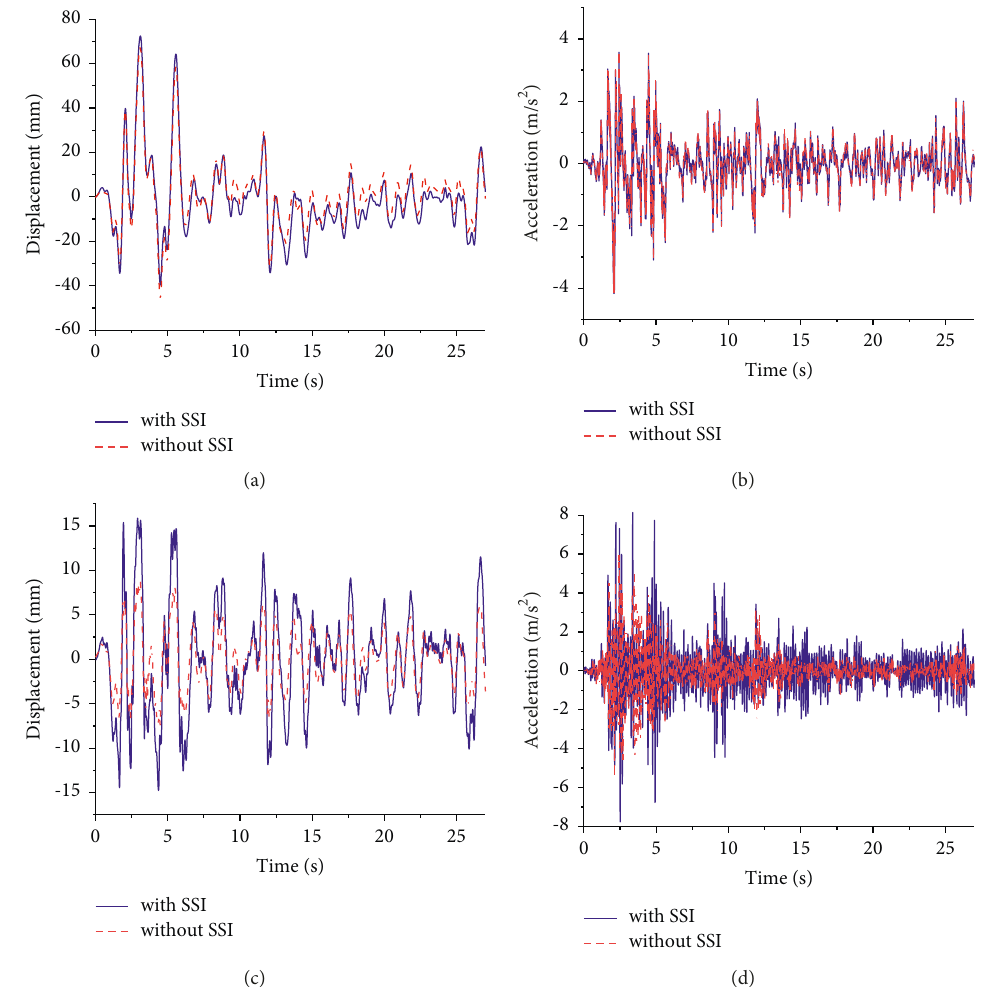
Figure 8: Comparison of the dynamic responses of the main beam and the pier top under ElCentro wave. (a) Displacement of the main beam. (b) Acceleration of the main beam. (c) Displacement of the pier top. (d) Acceleration of the pier